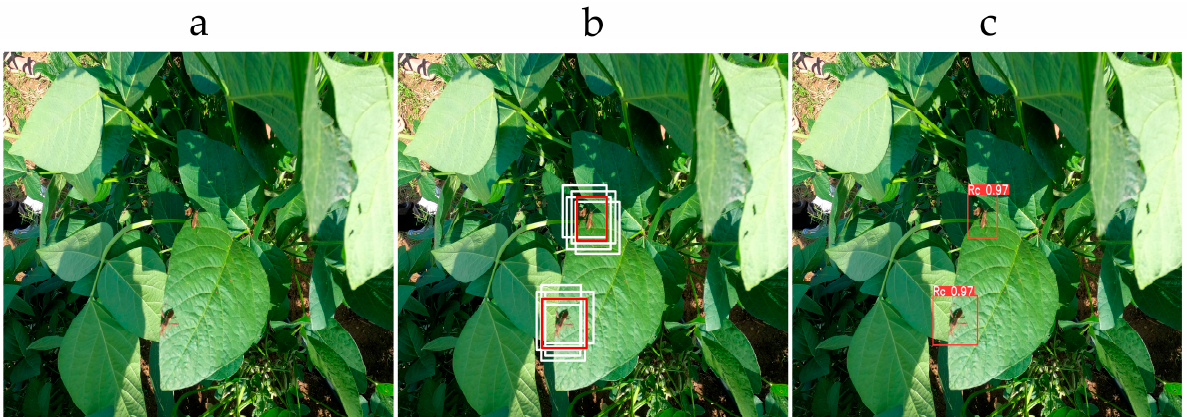
Figure 11. Detection outputs using the application with R. pedestris on the web. ( a ) Original image before submission to the web app; ( b ) after submission to the web app, it is detected with YOLOv3; ( c ) the best IOU score detected among the bounding boxes. Table 2. C/I with a confidence score and run times for iteration.